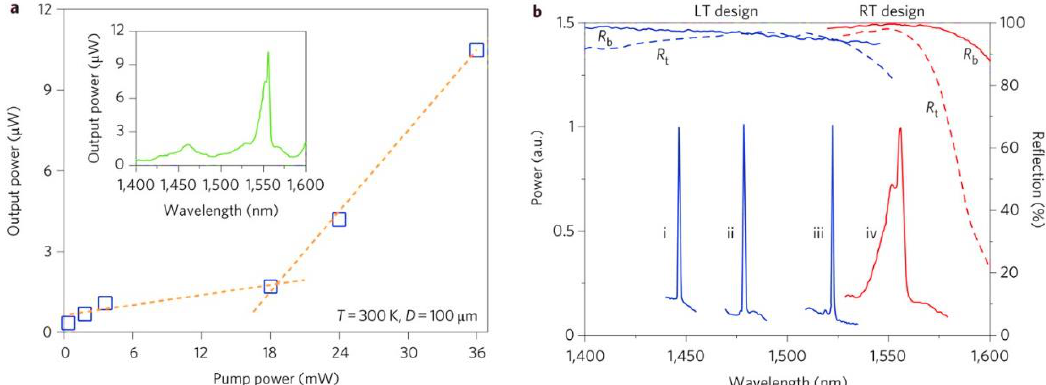
Figure 3. ( a ) Laser Light-light (L-L) curve at room temperature for the RT design of the MR-VCSEL device. Inset: measured spectral output above the threshold at a pump power of 36 mW, ( b ) Measured MR-VCSEL spectral outputs at different temperatures for both LT and RT designs: (i) T = 10 K; (ii) T = 50 K; (iii) T = 120 K; (iv) T = 300 K. Portions of measured top ( R t , dash lines) and bottom ( R b , solid lines) reflection spectra are also shown for both LT and RT designs (reprinted from [12]).